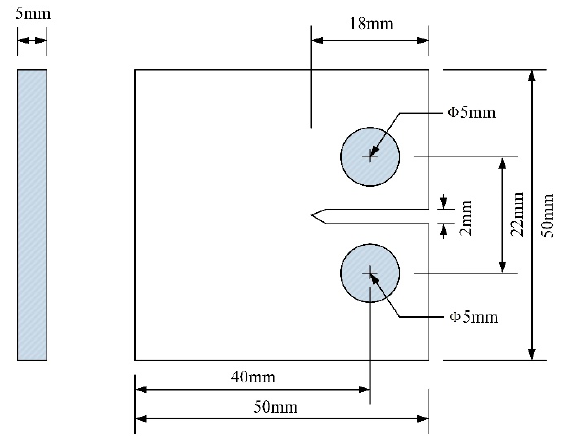
Figure 3. Illustration of the specimen geometry.